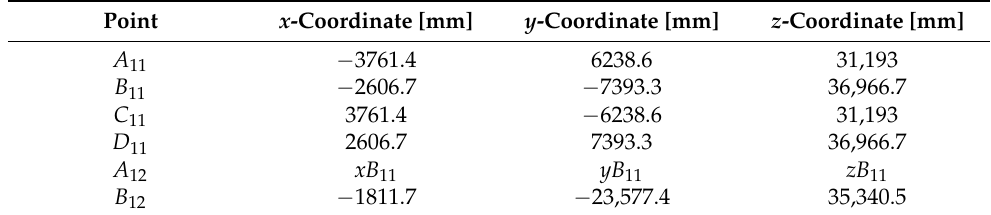
Table A7. The coordinates of the vertices A ij , B ij , C ij , D ij (for i , j = 1, 2) of the eaves edge net B v 1 (and the second structure Σ 2